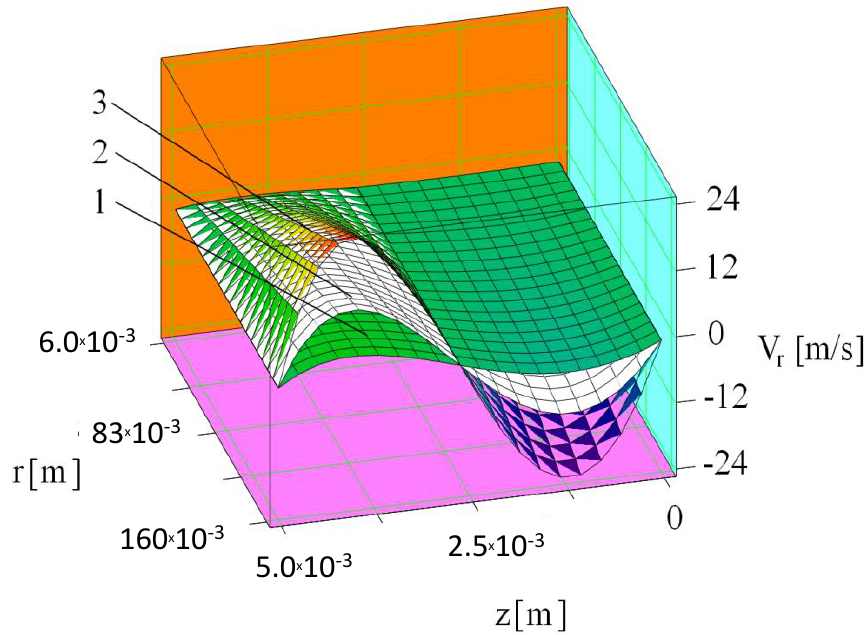
Figure 6. Graphs of the radial velocity component for different values of angular velocity within the disk gap h = 5·× 10 –3 m: 1– ω = 8 s −1 ; 2– ω = 14 s −1 ; 3– ω = 20 s −1 .